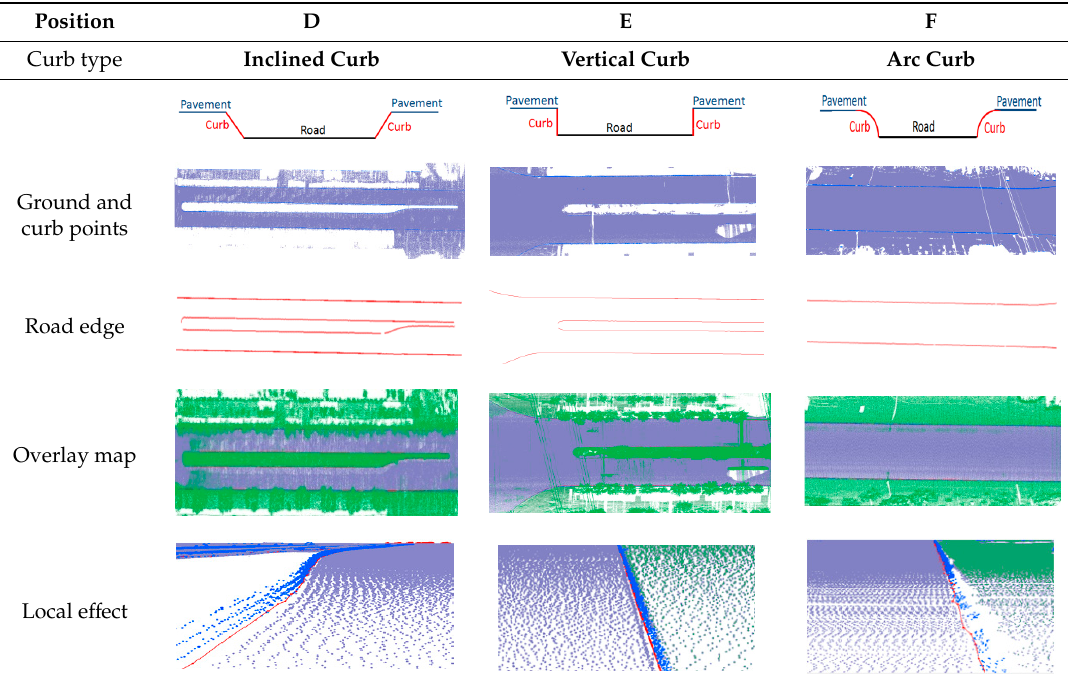
Table 4. Extraction results for three different types of road curbs.